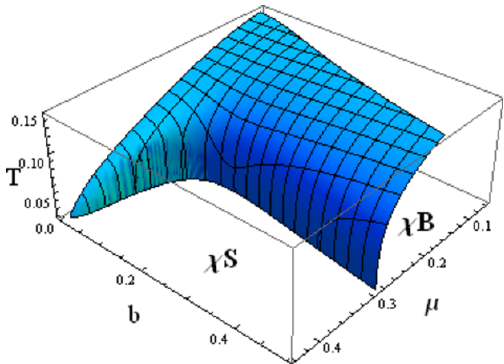
Figure 9 . The 3D phase diagram in the parameter space ( b; (cid:22); T ). Projections onto the ( b; (cid:22) ) and ( T; b ) planes, shown in (cid:12)gures 7 and 8, correspond to (cid:12)xing T or (cid:22) respectively. The projection onto the ( T; (cid:22) ) plane corresponds to (cid:12)xing b